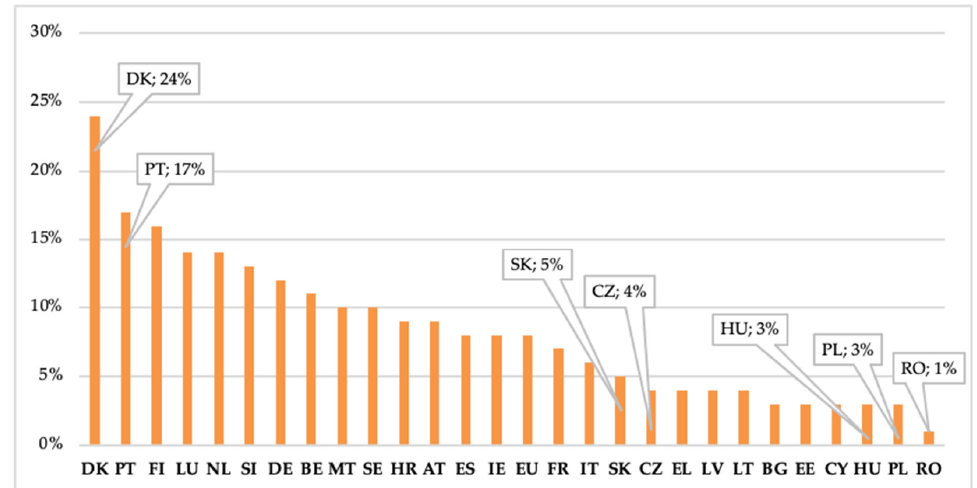
Figure 9. Companies using Industry 4.0 components (% of enterprises). Source: Authors’ compilation, according to [71] and cumulative data.